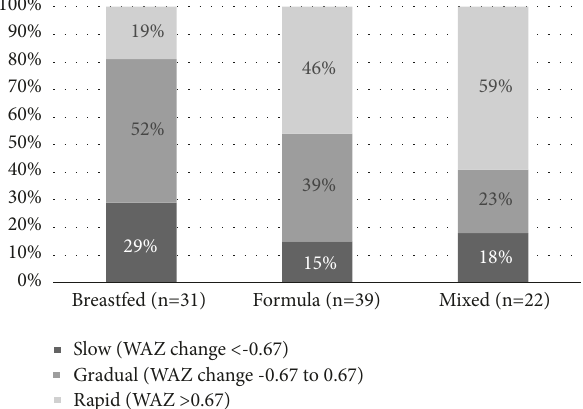
Figure 1: Rate of weight gain between birth and 6 months of age for breastfed, formula fed, and mixed fed infants (n=92). The rate of weight gain was calculated as weight-for-age z-score at 6 months of age minus weight-for-age z-score at birth. Values are percentages of infants in weight gain categories based on weight-for-age z-score change as slow ( < -0.67), gradual (-0.67 to 0.67), or rapid ( > 0.67). We excluded the 35 infants who were complementary fed (and also previouslyfed by thealternateFP), therewere 37 infants in total who experiencedrapidweightgainby6monthsofage;again,FPandtype of weight gain were related ( 𝜒 2 , p < 0.05).